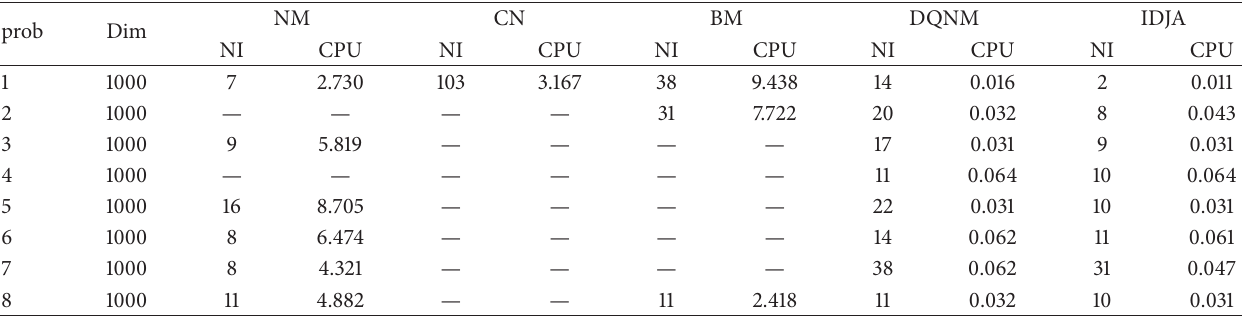
Table 5: Numerical results of NM, CN, BM, DQNM, and IDJA